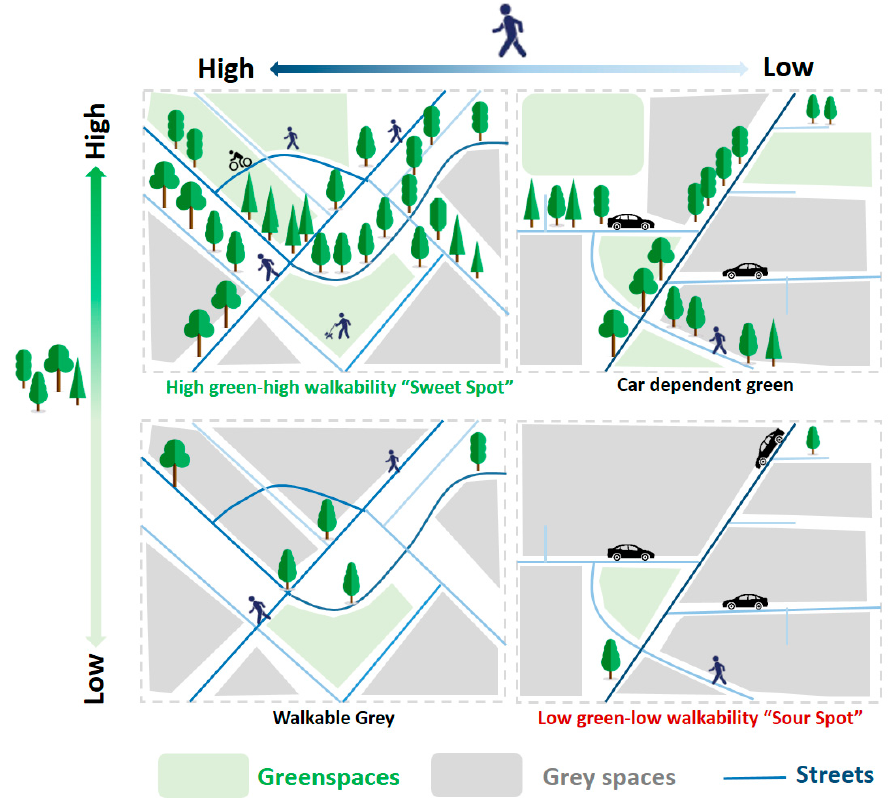
Figure 2. Four-way patterns of the relationship between greenness and walkability. Gray spaces indicate areas that are built up or are otherwise not green.